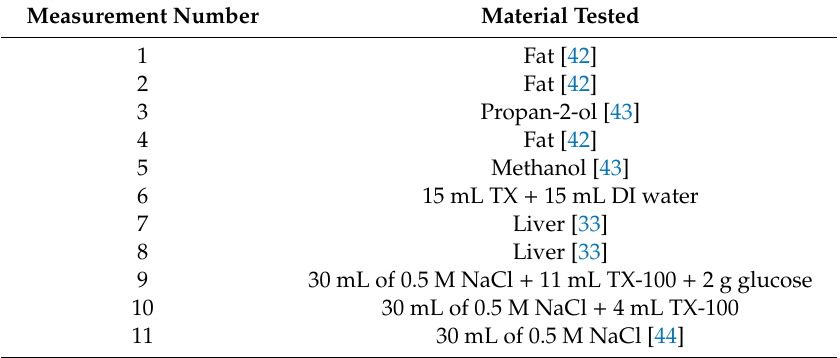
Table 4. The maximum number of iterations and corresponding loss values calculated using the last two iterations when training the ANN on different fractions of training data with respect to the validation data.